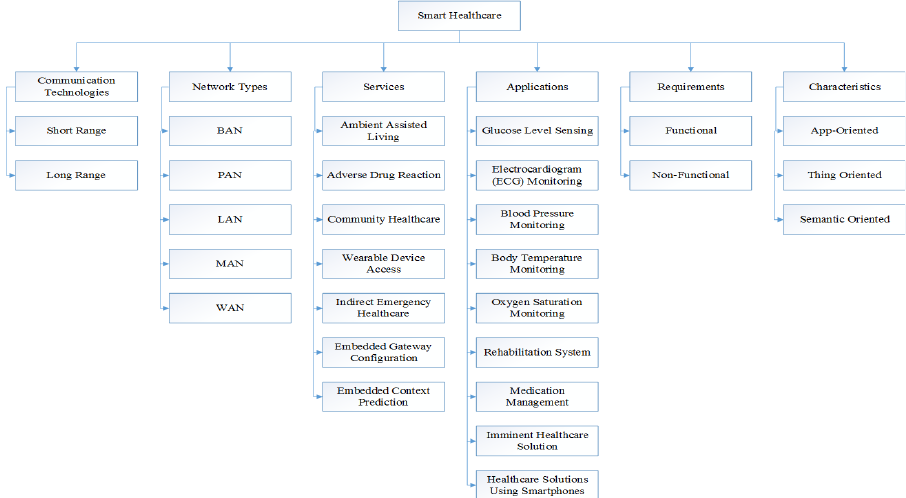
Figure 2. Taxonomy of smart health-care and its